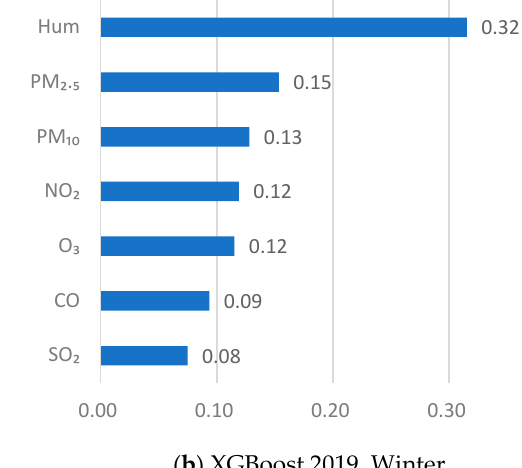
Table 2. Correlation coefficients between seasonal average visibility and various types of features in Qingdao.